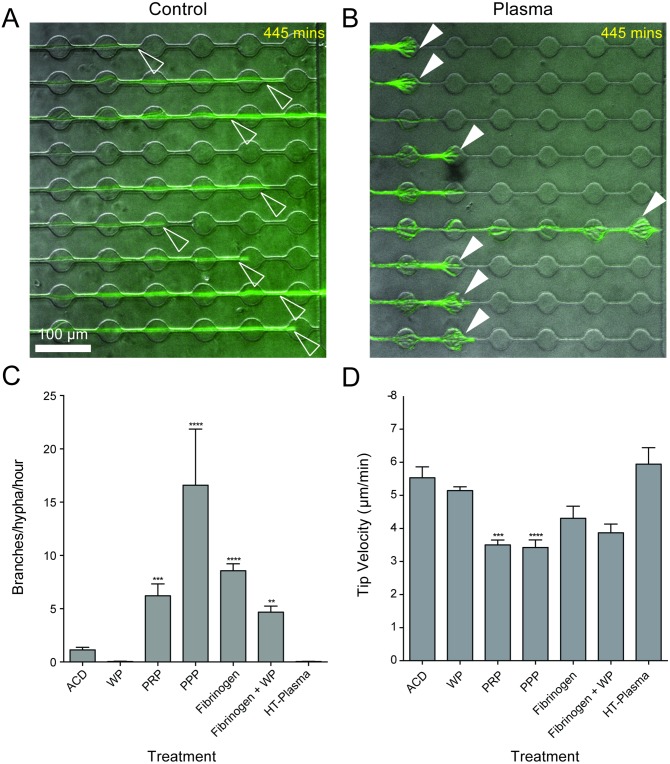
Hyperbranching is induced by heat-labile plasma factors independently of complement, platelets, and clot formation.(A) Representative image of hyphal growth (green, EGFP, open white arrowheads) in the absence of treatment (B) Representative image of plasma-induced hyperbranching (green, EGFP, filled white arrowheads) (C) Plasma preparations, but not washed platelets, induce hyphal hyperbranching. This effect could be phenocopied by addition of Fibrinogen and abrogated by heat-treatment. (D) Hyphal velocity was significantly slower during growth toward platelet rich plasma and PPP, but was not effected by washed platelets (WP). N ≥ 18 hyphae scored per condition from 3 experiments. Error bars: mean ± SEM. Statistics: One-way ANOVA with Tukey’s post test. Adjusted p values: *p≤0.05, **p≤0.01, ***p≤0.001, ****p≤0.0001.